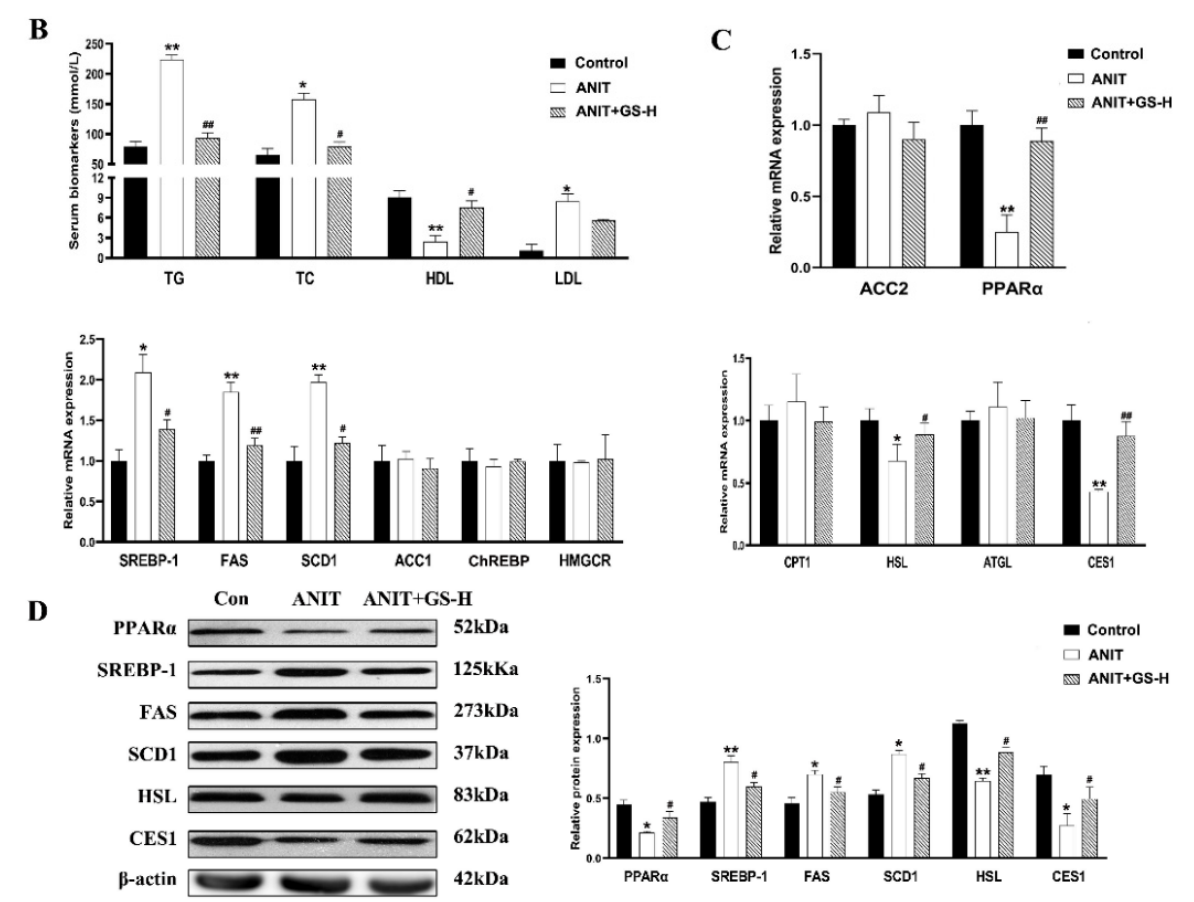
Figure 4. GS treatment improved fat metabolism gene profile in murine liver. ( A ) Morphology of frozen liver sections as tested by Oil Red O staining (scale bar, 20 µ m). Red arrows, lipid droplets. ( B ) Levels of TG, TC, HDL, and LDL in serum of mice. ( C , D ) The levels of mRNAs (ACC2, PPAR α , SREBP-1, FAS, SCD1, ACC1, ChREBP, HMGCR) and proteins (PPAR α , SREBP-1, FAS, SCD1,